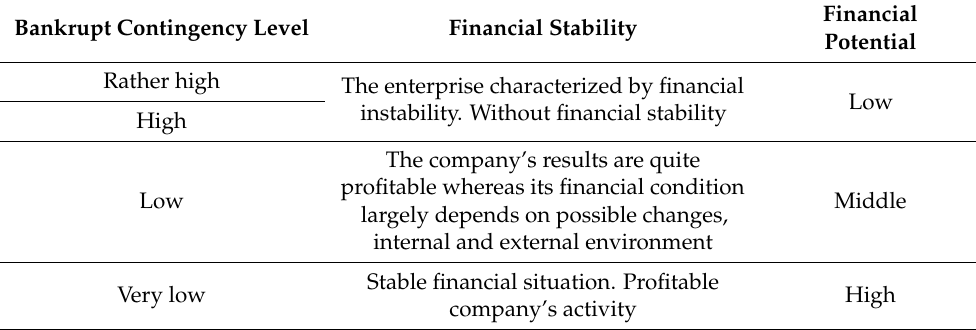
Table 4. Altman’s model approbation-based matrix for determining the level of financial potential of GDNO.